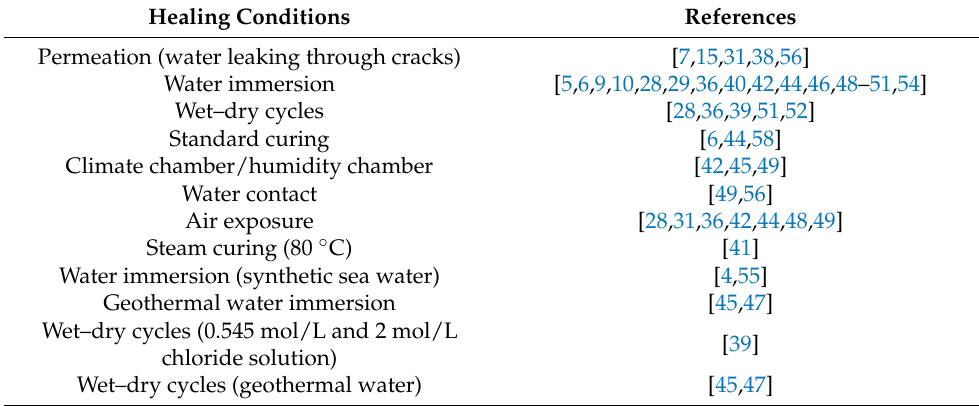
Table 3. Healing